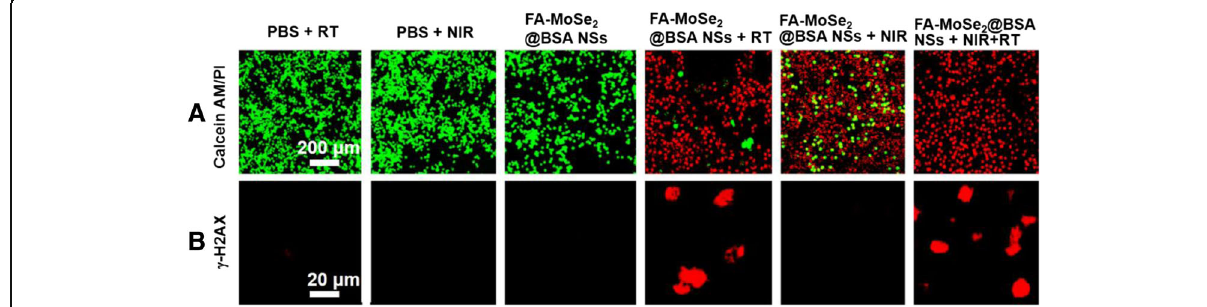
Fig. 6 a Live − dead and b γ -H2AX staining images of 4T1 cells treated with PBS + RT, PBS + NIR, FA-MoSe 2 @BSA NSs, FA-MoSe 2 @BSA NSs +